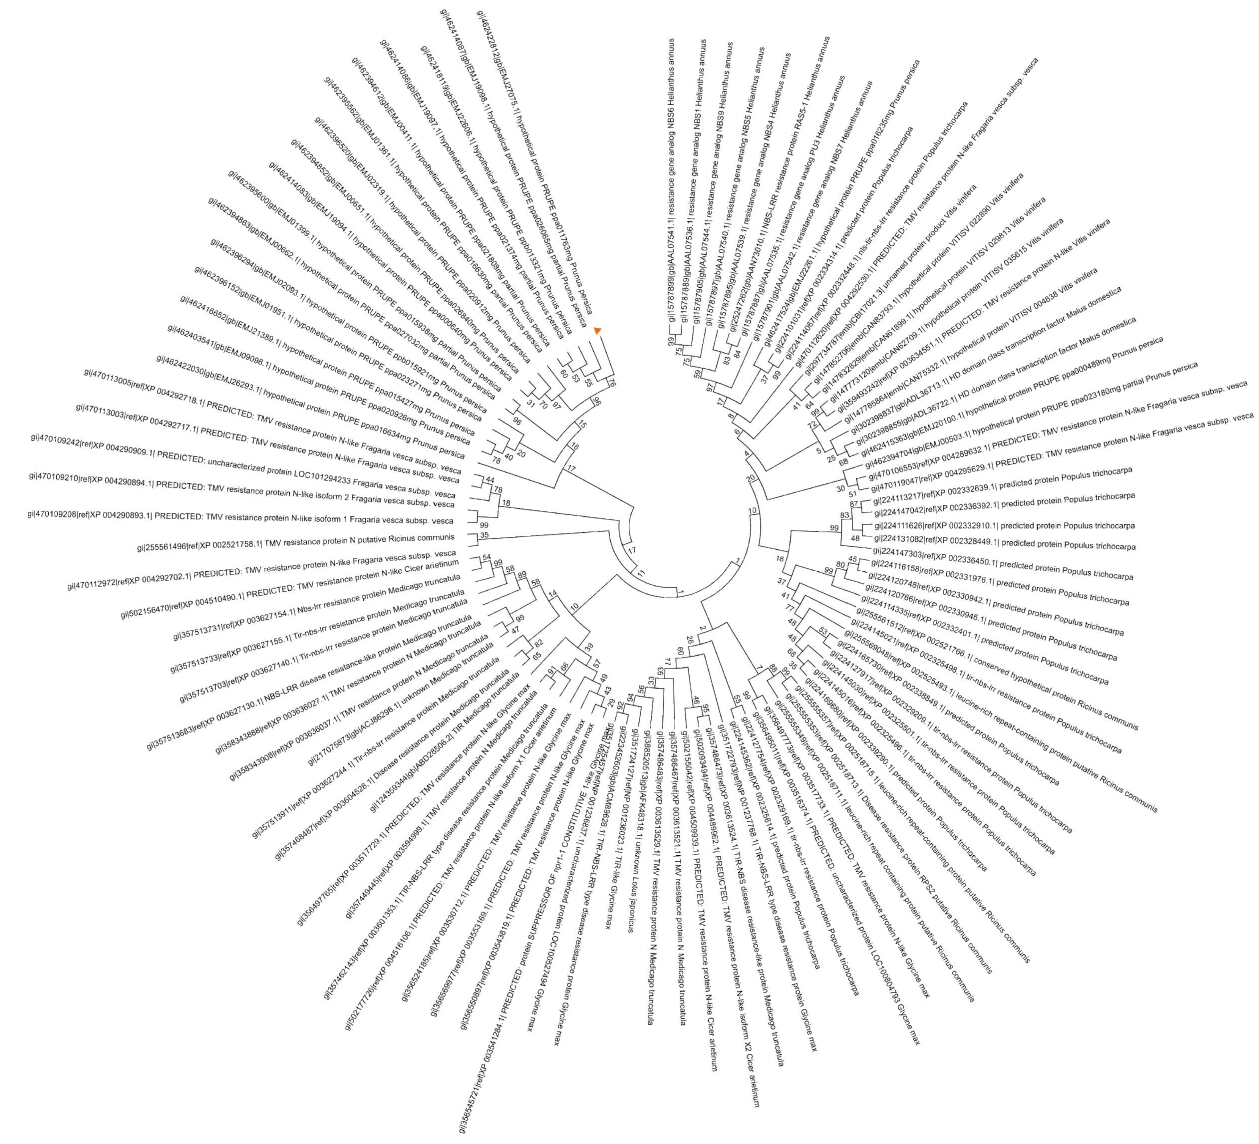
Figure 5. Evolutionary relationships of taxa. The bootstrap consensus tree inferred from 1000 replicates is taken to represent the evolutionary history of the taxa analyzed. Branches corresponding to partitions reproduced in less than 50% bootstrap replicates are collapsed. The evolutionary distances were computed using the Poisson correction method and are in the units of the number of amino acid substitutions per site. The analysis involved 100 amino acid sequences. All positions containing gaps and missing data were eliminated. There were a total of 85 positions in the final dataset.